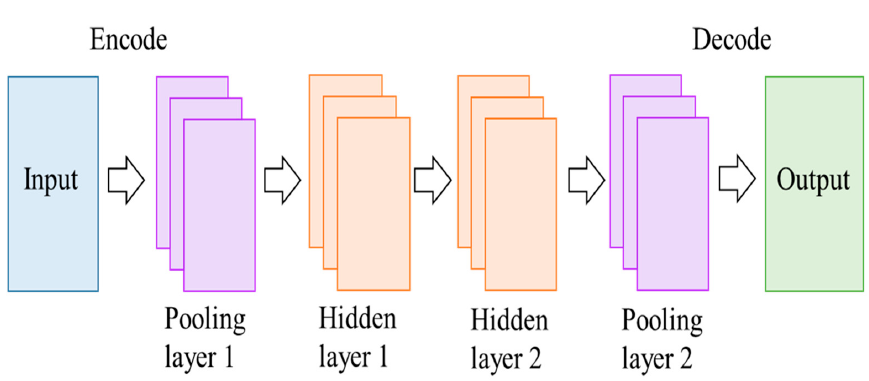
Figure 11. Architecture of the proposed CNN model using an auto encoding system.